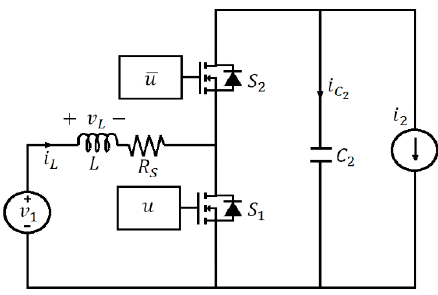
Figure 3. Circuit diagram of the bidirectional half-bridge DC–DC converter (BHBC) operating in boost mode.